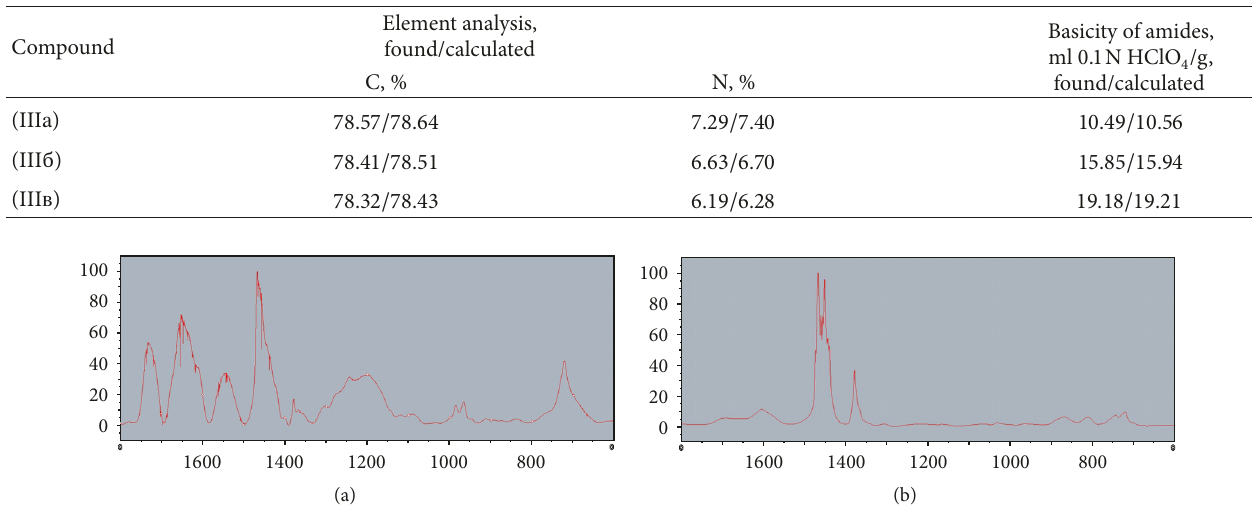
Figure 3: IR spectra of the additives (a) and the original bitumen BND 60/90 (TAIF-NK)